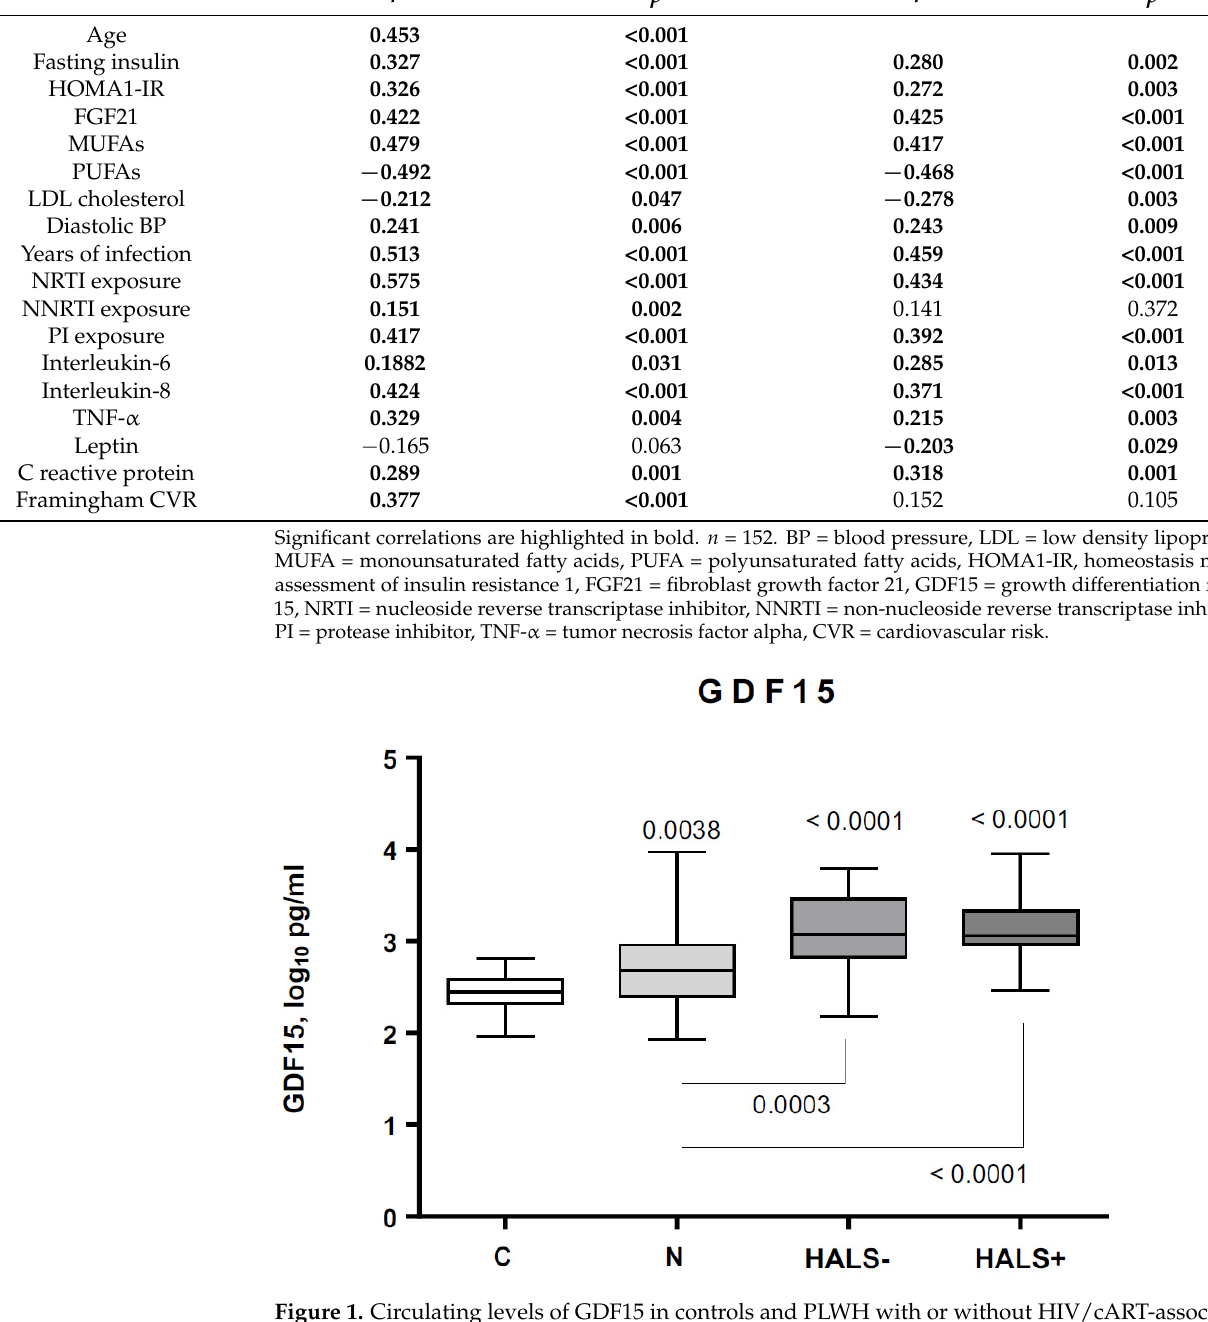
Figure 1. Circulating levels of GDF15 in controls and PLWH with or without HIV/cART-associated lipodystrophy (HALS) GDF15 = Growth differentiation factor 15; C = controls N = Naive HIV-infected patients HALS − = HIV-infected patients without HIV/cART-associated lipodystrophy HALS+ = HIV-infected patients with HIV/cART-associated lipodystrophy.